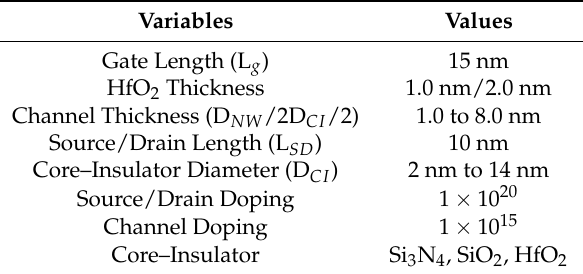
Figure 2. The overall dimension of CIGAA and GAA: ( a ) parameters used for GAA; ( b ) parameters used for CIGAA. Table 1. Design parameter values for CIGAA and